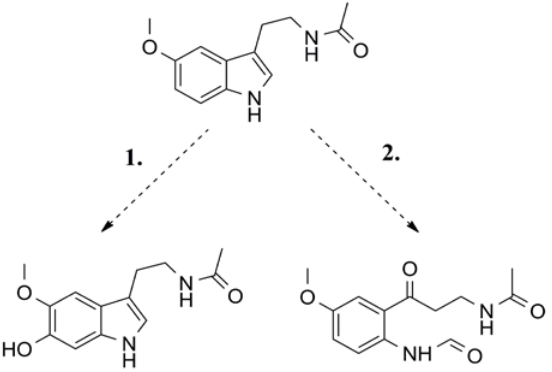
Figure 1. Heart rate (HR) and respiratory rate (RR) variations during drug administration. At time T HR were similar in both.